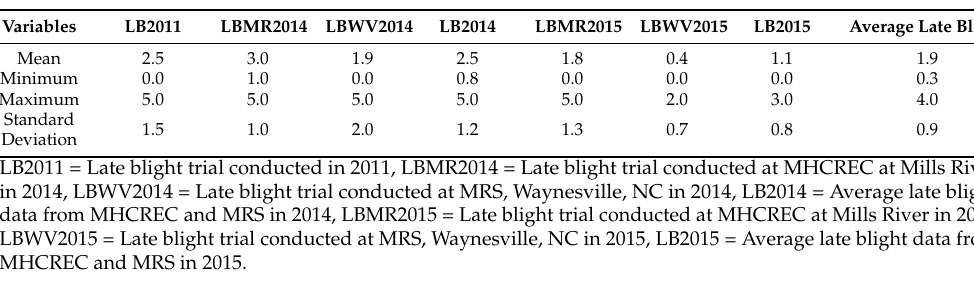
Table 1. Descriptive statistics for late blight severity in tomato populations evaluated in various environments in North Carolina.